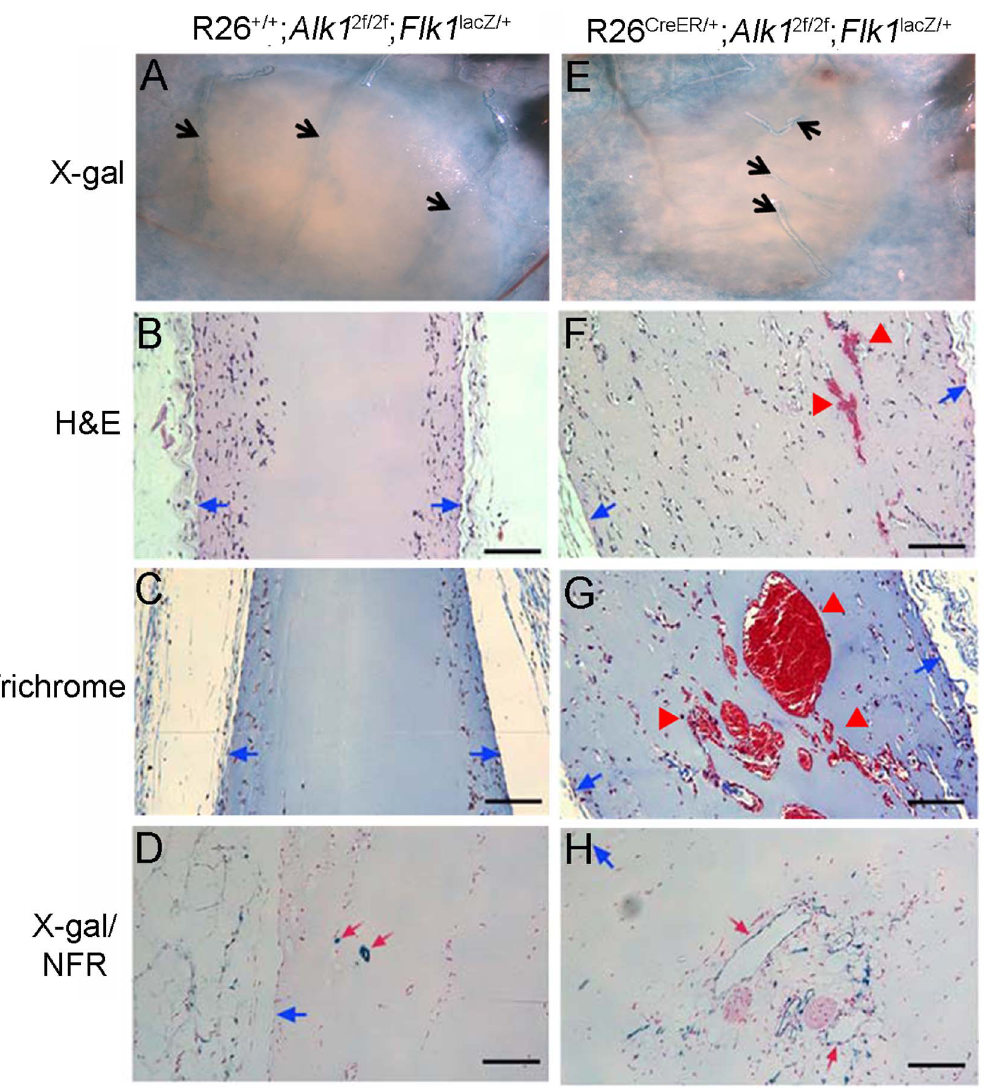
Figure 6. Alk1 -deficient ECs exhibit higher migratory and/or invasive characteristics invivo as well as pro-angiogenic properties. Matrigels containing 250 ng/ml of bFGF were subcutaneously implanted into TM-injected R26 + / + ; Alk1 2f/2f ; Flk1 lacZ/ + (A–D) or R26 CreER/ + ; Alk1 2f/ 2f ; Flk1 lacZ/ + (E–H) mice and were harvested eight days later. A and E . Gross view of X-gal stained skin containing the Matrigel plugs. Black arrows indicate blood vessels running over (A) or into (E) the plugs. B–G . H & E (B, F) and trichrome (C, G) staining of the plugs showing the migrated cells in the plugs. Blue arrows indicate the margin of the plugs, and red arrowheads indicate the blood vessels containing red blood cells. While the migrating cells were found near the edges of the plugs in the control mice (B, C), such cells were found in broad areas of the plugs and formed irregular and distended blood vessels in the mutant mice (F, G). D and H . Sections of whole mount X-gal stained plugs were counter-stained with nuclear-fast red (NFR), showing a few small nascent blood vessels in the controls (D) and vessels with irregular shapes and enlarged lumen in the mutants (H). Red arrows indicate X-gal positive vascular ECs.